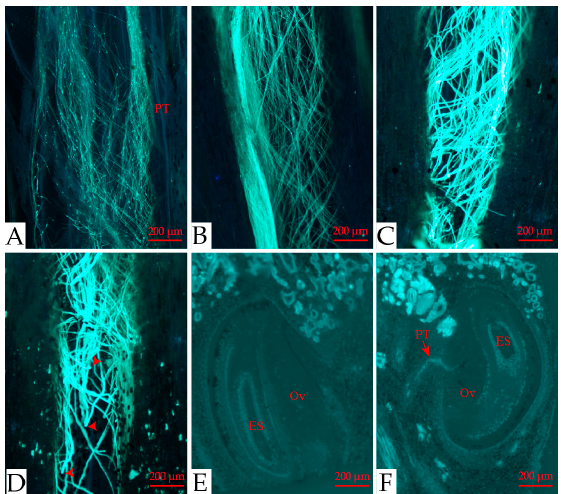
Figure 4. Pollen tube growth of Schima superba for self- and cross-pollination treatments in style and ovary. Note: ( A ) pollen tubes resulting from cross-pollination grew to the medial style at 12 h; ( B ) pollen tubes resulting from self-pollination grew to the medial style at 12 h; ( C ) pollen tubes from cross-pollination grew to the base of the style at 36 h; ( D ) pollen tubes resulting from self-pollination grew to the base of the style at 36 h with part retardation (shown by red arrows); ( E ) cross-pollinated pollen tubes entered the ovary; ( F ) none of the self-pollinated pollen tubes entered the ovary. SEM resolution of 200 μ m.